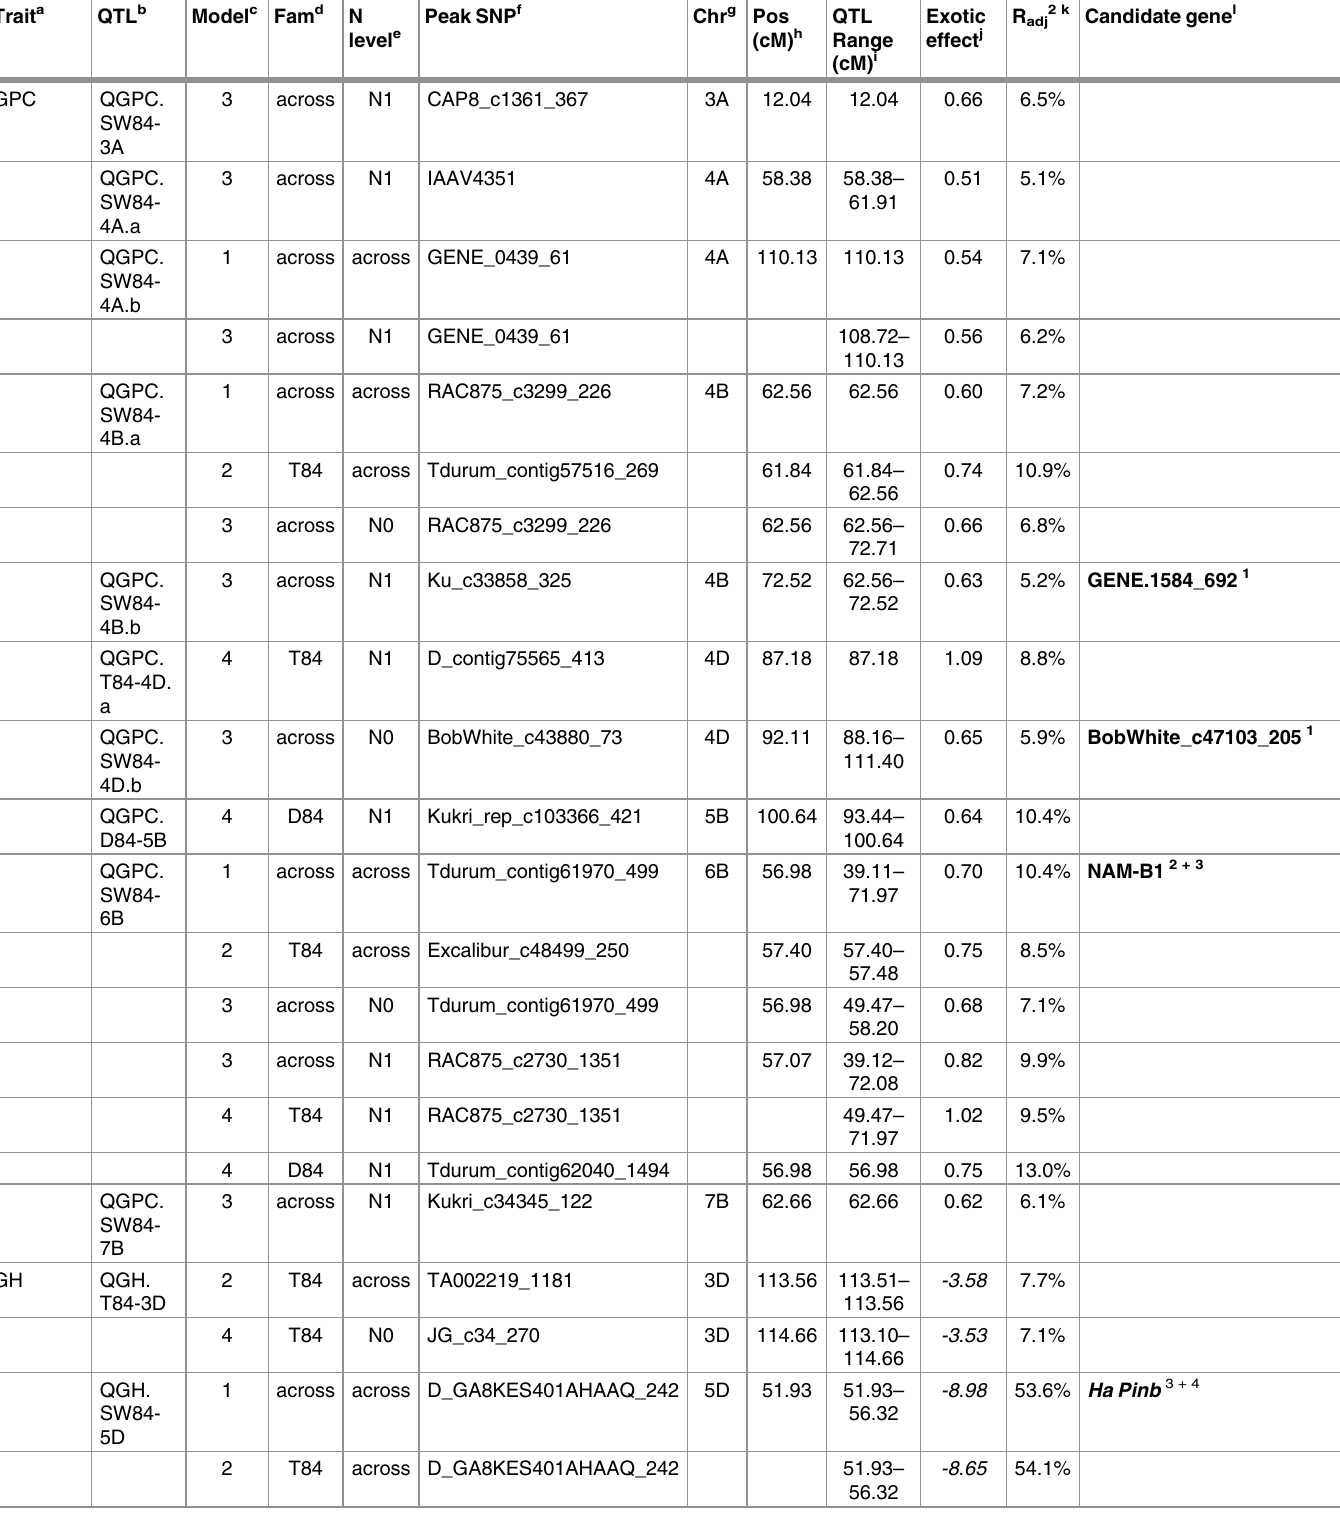
Table 4. List of 16 grain quality QTL detected across or within two families of SW84 and across or within two N levels, respectively. Trait a QTL